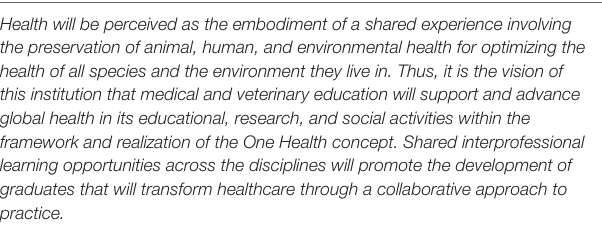
TABLE 6 | Vision for the Institution. Health will be perceived as the embodiment of a shared experience involving the preservation of animal, human, and environmental health for optimizing the health of all species and the environment they live in. Thus, it is the vision of this institution that medical and veterinary education will support and advance global health in its educational, research, and social activities within the framework and realization of the One Health concept. Shared interprofessional learning opportunities across the disciplines will promote the development of graduates that will transform healthcare through a collaborative approach to